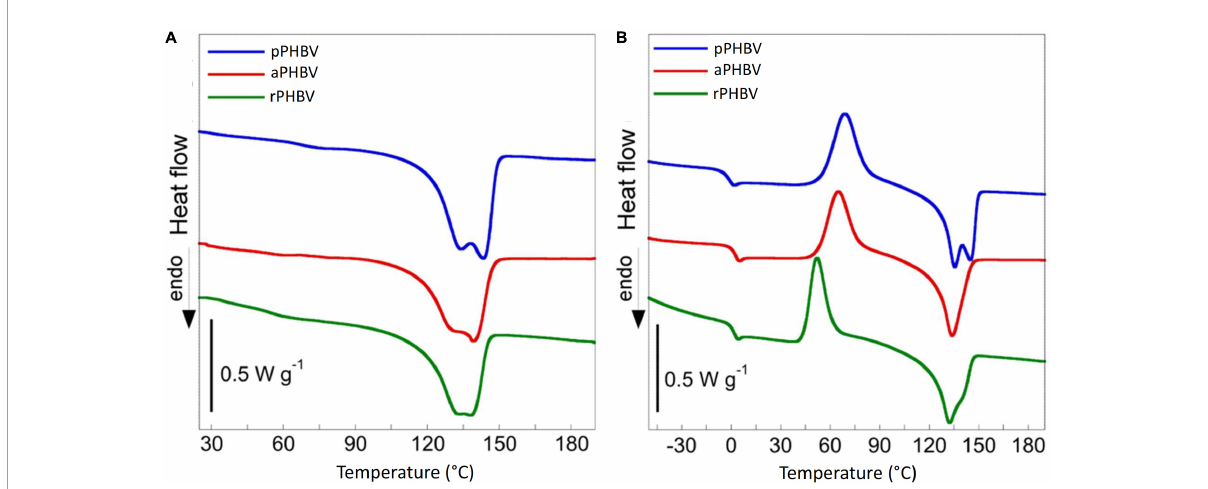
FIGURE6 Differential scanning calorimetry thermograms of PHBV produced in the wasted bread/seawater substrate: pPHBV, obtained from the CHCl 3 :H 2 O separation and the precipitation with cold ethanol; rPHBV, obtained by the replacement of the CHCl 3 :H 2 O separation with repeated washing with water; aPHBV, obtained by the replacement of the CHCl 3 :H 2 O separation with repeated washing with water but followed by solubilization in CHCl 3 and purification with cold ethanol. (A) First heating scan from 25 to 190 ◦ C at 10 ◦ C min − 1 , (B) second heating scan from − 70 to 190 ◦ C at 10 ◦ C min − 1 . The DSC curves were vertically shifted for sake of clarity.